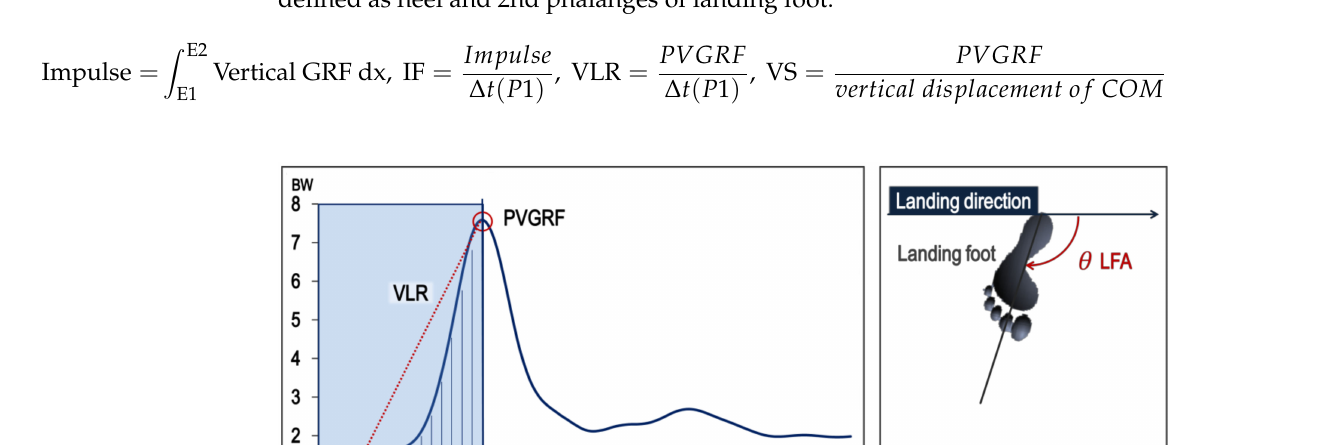
Figure 3b by the PVGRF at the landing and the vertical displacement of COM [17]. The LFA defined the foot segment opening angle for the jumping and landing direction when the jumping kick landing was completed (Figure 3c). At this time, the foot segment was defined as heel and 2nd phalanges of landing foot.